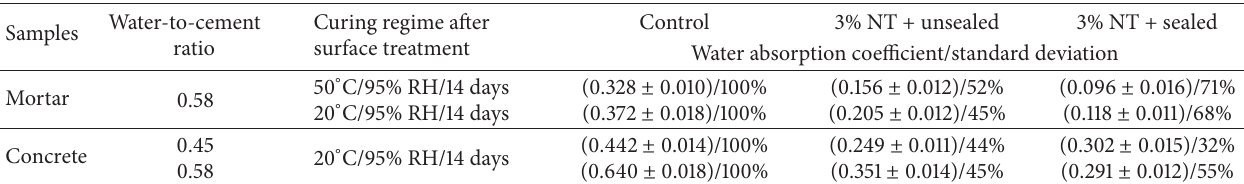
Table 5: Water absorption coefficient of hardened mortars and concretes at 28